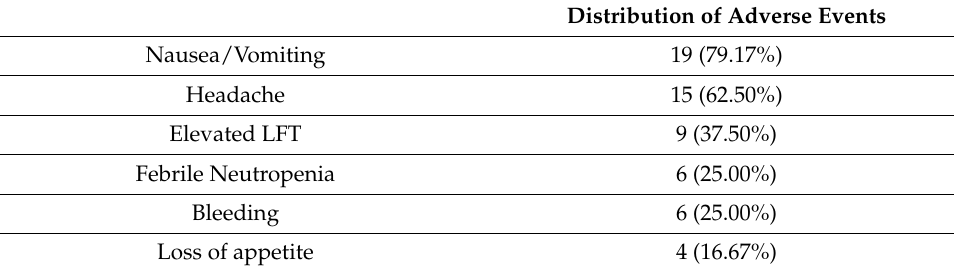
Table 6. Distribution of adverse events associated with